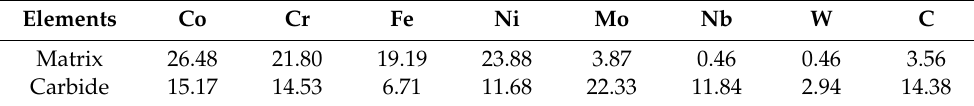
Table 1. Chemical compositions of the two phases in the HEA by EPMA (at.%).